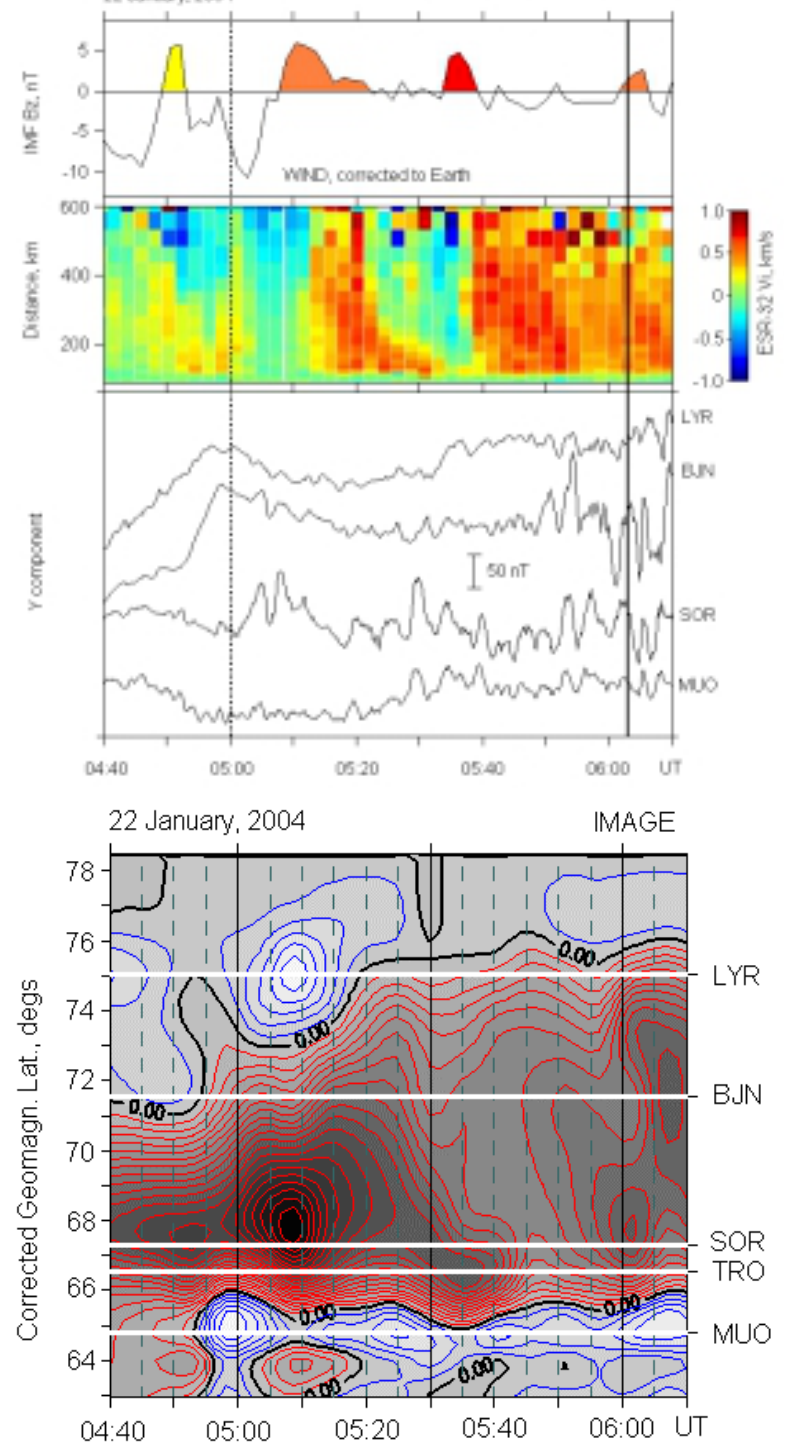
Fig. 8. Top panel: the azimuthal plasma flow and Ps6 activity are compared with the IMF B z variations; the dashed line indicate the substorm onset, while the bold line refers to the moment of torch appearance, positive values of the velocity correspond to the plasma movement toward the radar. Bottom panel: dynamics of auroral electrojet; the red (blue) contours correspond to westward (eastward) Hall current, the darker areas indicate current enhancements.